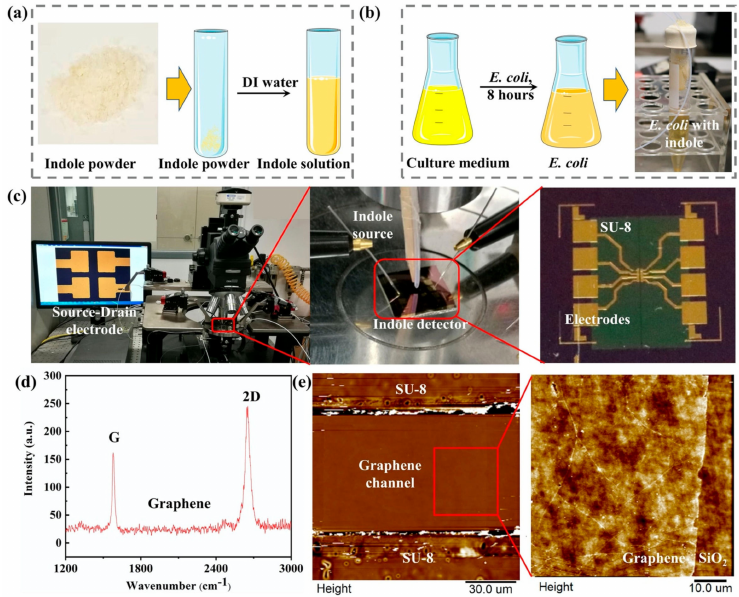
Figure 2. ( a ) The preparation of the as-prepared indole solution. ( b ) The preparation of metabolic indole from E. coli . ( c ) The optical image of a G-FET indole detector and the experimental setup of the indole detection on a probe station. ( d ) Raman spectroscopy of graphene. ( e ) AFM image of the graphene